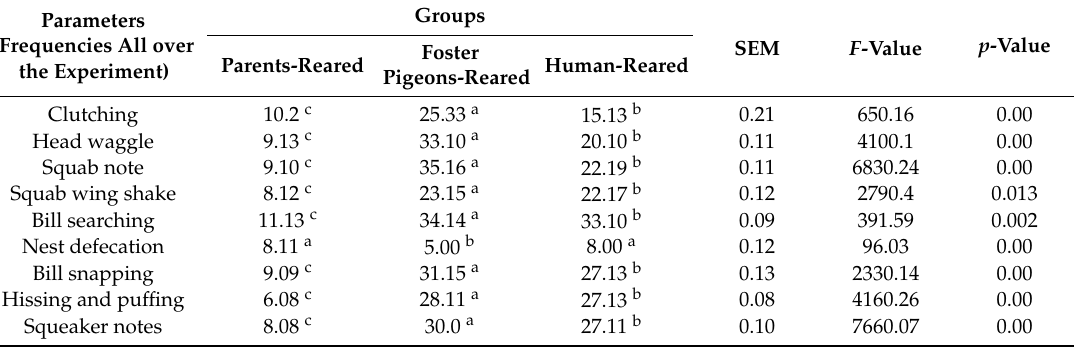
Table 3. E ff ect of di ff erent fostering methods on squab’s behavior during the brooding